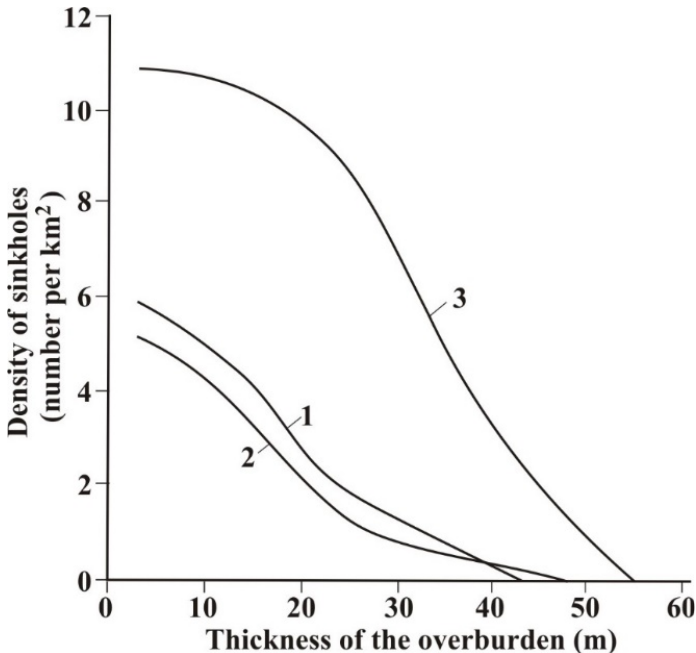
Figure 5. Relation between the number of subsidence dolines and cover thickness on Ukraine gyp— Scheme 22 [23]. 1. in the Seret-Nichlava interfluve (entrenched karst), 2. in the Cerny Potok area (subjacent karst), 3. in the Zoloushka cave area (subjacent karst). Cover thickness is affected by accumulation and denudation. A small cover thickness of accumulation origin develops during the formation of loess, moraine (ground moraine) and weathering residue. These accumulation environments, particularly if the bedrock